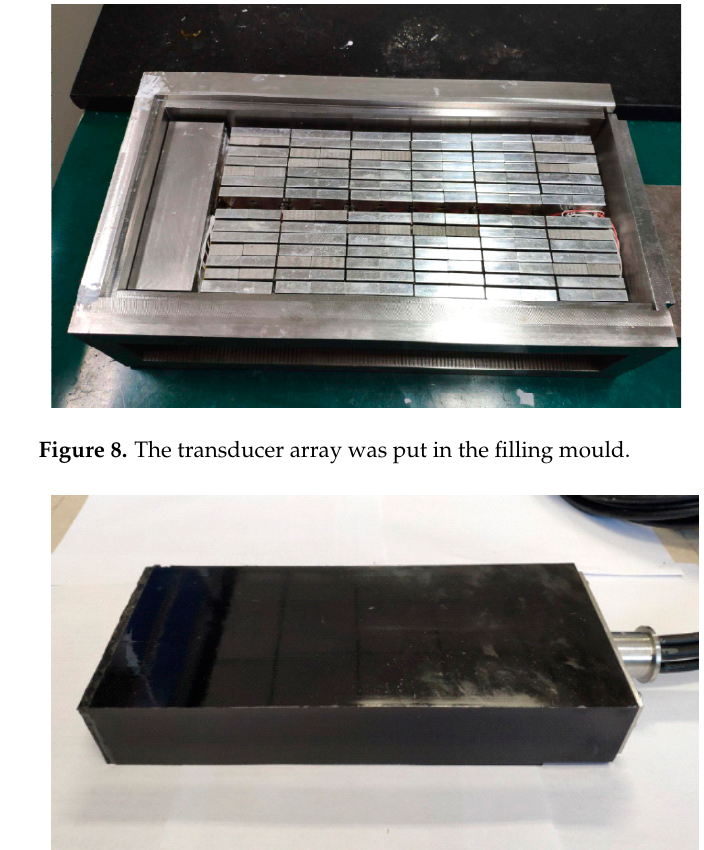
8 of 14 Figure 7. Diagrams of array elements. Table 3. Electrical performances of array elements. Sample No.